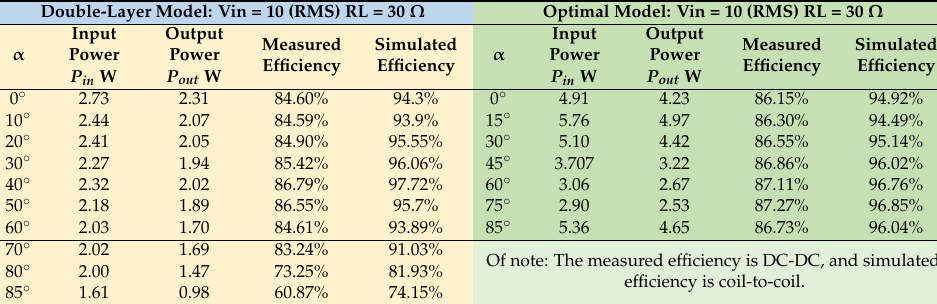
Table 5. Input/output power and efficiency of the double-layer windings and optimal model.